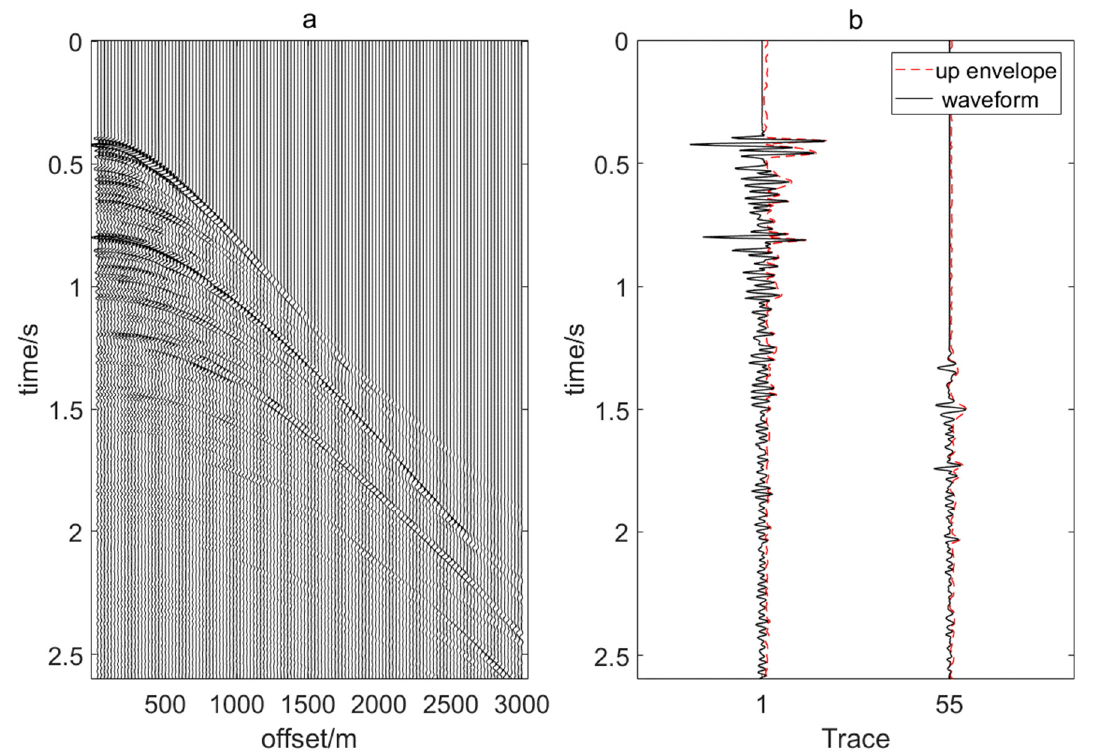
Figure 9. ( a ) Field CMP gather; ( b ) waveform and upper envelope of the two traces. To test the reconstruction performance, we designed empty regions (from trace 61 to trace 70) in the seismic data, as shown in Figure 10a. From Figure 10b,c the WRT was significantly better than the CGRT with respect to the resolution in the Radon panel. Then, we used the CGRT and WRT to reconstruct the field seismic data gather. The reconstruc- tion result is shown in Figure 11, and the area between the two red lines is the reconstruc- tion region. It is clear that the reconstruction region of the WRT was better than the CGRT.